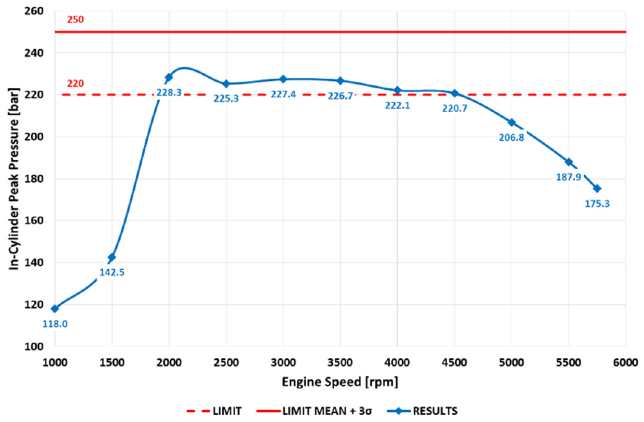
Figure 11. In-cylinder pressure trace simulation result related to engine speed.